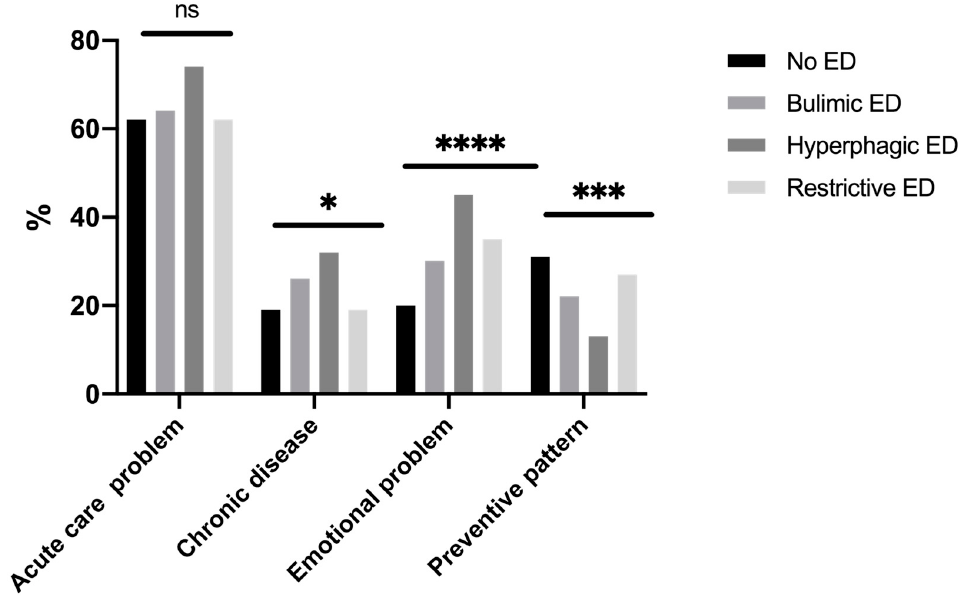
Figure 4. Reasons for foregone care with a general practitioner in the past 12 months ( n = 1247). ns: ns: non significant. *: p < 0.05. ***: p < 0.001. ****: p < non significant. *: p < 0.05. ***: p < 0.001. ****: p < 0.0001.